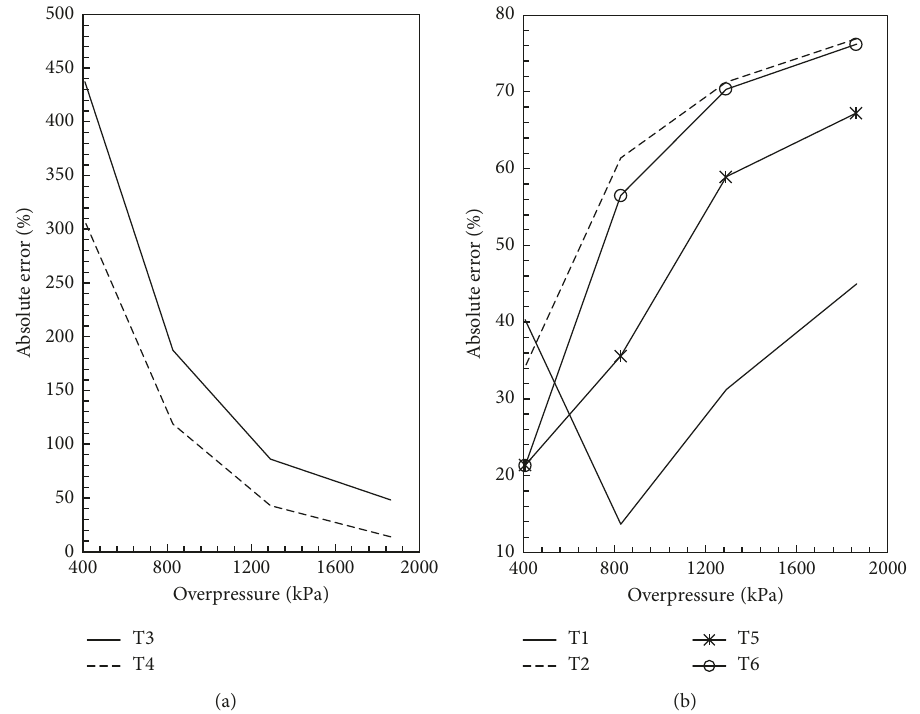
Figure 6: Variation of error in estimated peak displacement using constrained modulus determined from different experimental techniques: (a) T3 and T4 and (b) T1, T2, T5, and T6. T1: deduced from observed ground motion; T2: calculated from seismic velocity; T3: triaxial tests: initial loading; T4: dynamic 1-D compression test: initial loading; T5: triaxial tests: reloading; T6: resonant column test.